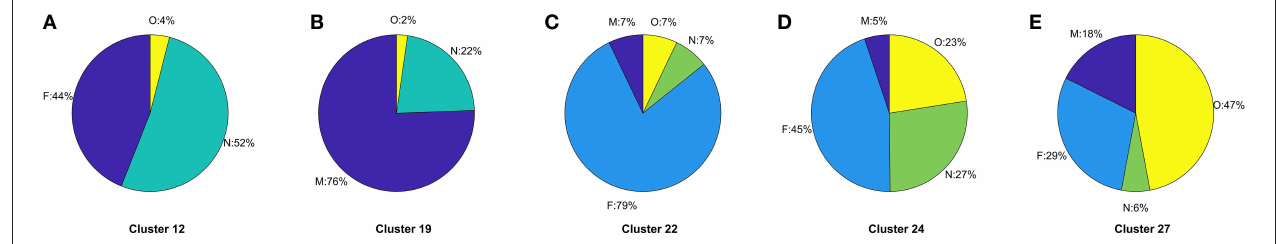
FIGURE 6 | (A–E) Typical distributions of Episode for the five archetype clusters in CMR data identified in Figure 3 listing the specific cluster the distribution arises from. Pie charts illustrate the frequency of Episode type and the proportion of missing (M), first (F), new (N), or ongoing (O) occurrence of respiratory infection listed in the CMR